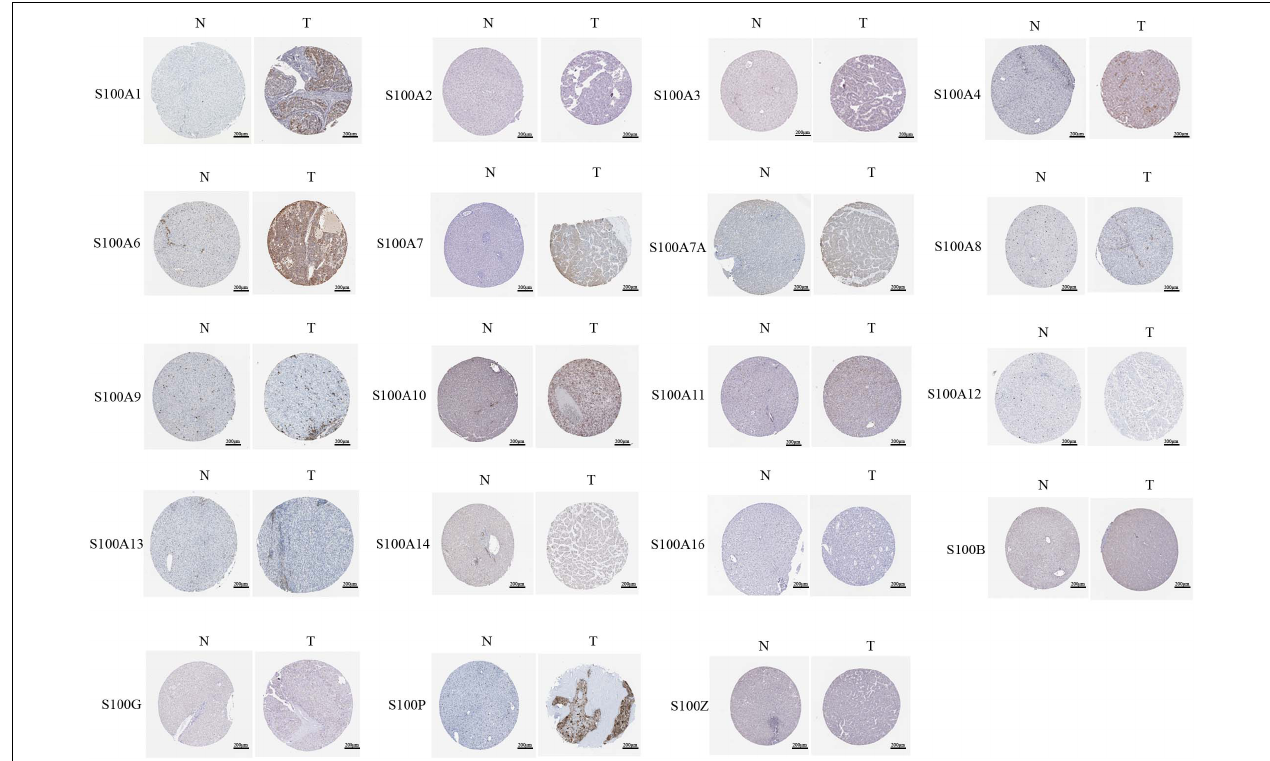
FIGURE 4 | Representative immunohistochemistry images of distinct S100s in HCC tissues and normal liver tissues (Human Protein Atlas). S100A5 protein expression was not shown by the database. Low protein expression of S100A7A was found in normal liver tissues and medium protein expression was observed in HCC tissues. All the other S100s proteins were not detected in normal liver tissues. Low protein expressions of S100A4/S100A11/S100B were observed in HCC tissues. Medium protein expressions of S100A1/S100A6/S100A7/S100A7A/S100A10/S100G/S100P were observed in HCC